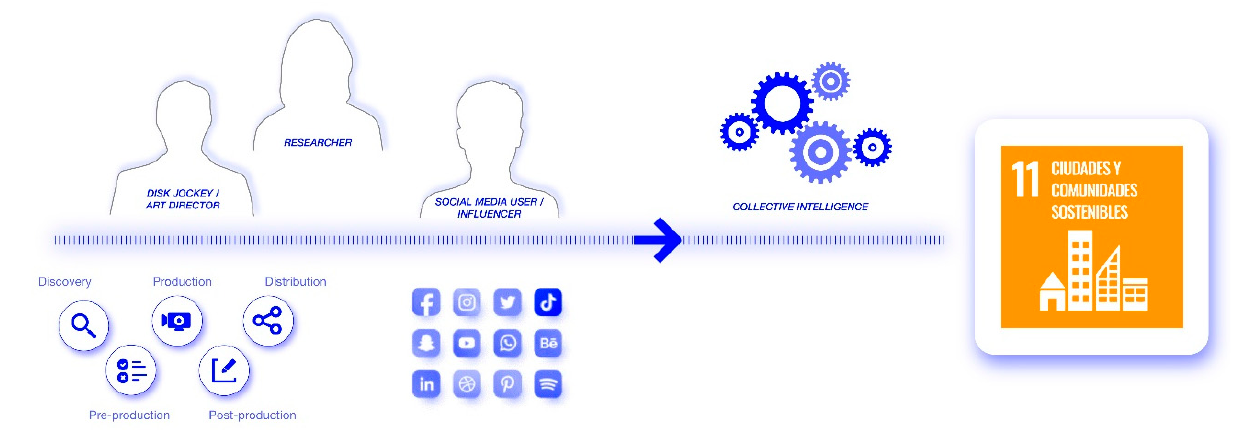
Figure 8. Conceptual diagram of the research method in which the postproduction work was combined with a presence on social networks. The purpose was collective intelligence and ultimately the Sustainable Development Goal 11, which refers to cities, within the 2030 Agenda. Source: TRAHERE’s own elaboration.